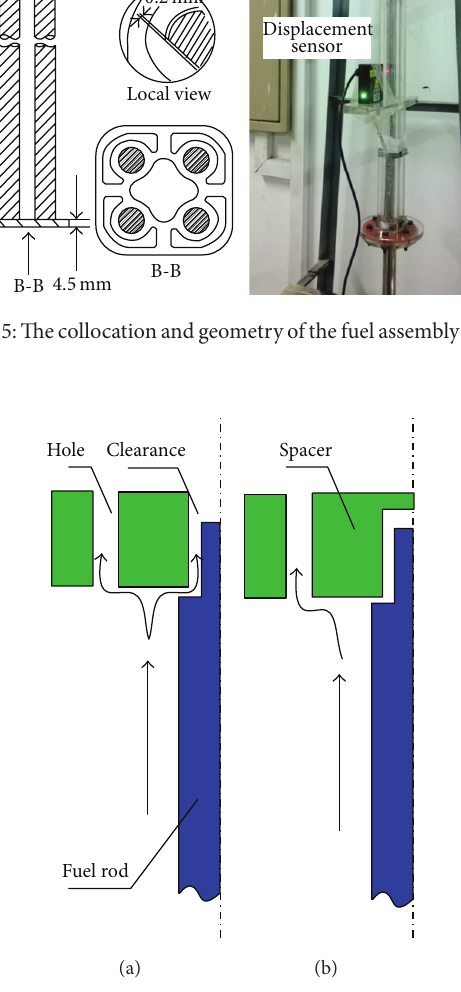
Figure 6: Schematic diagram of two types of spacers.